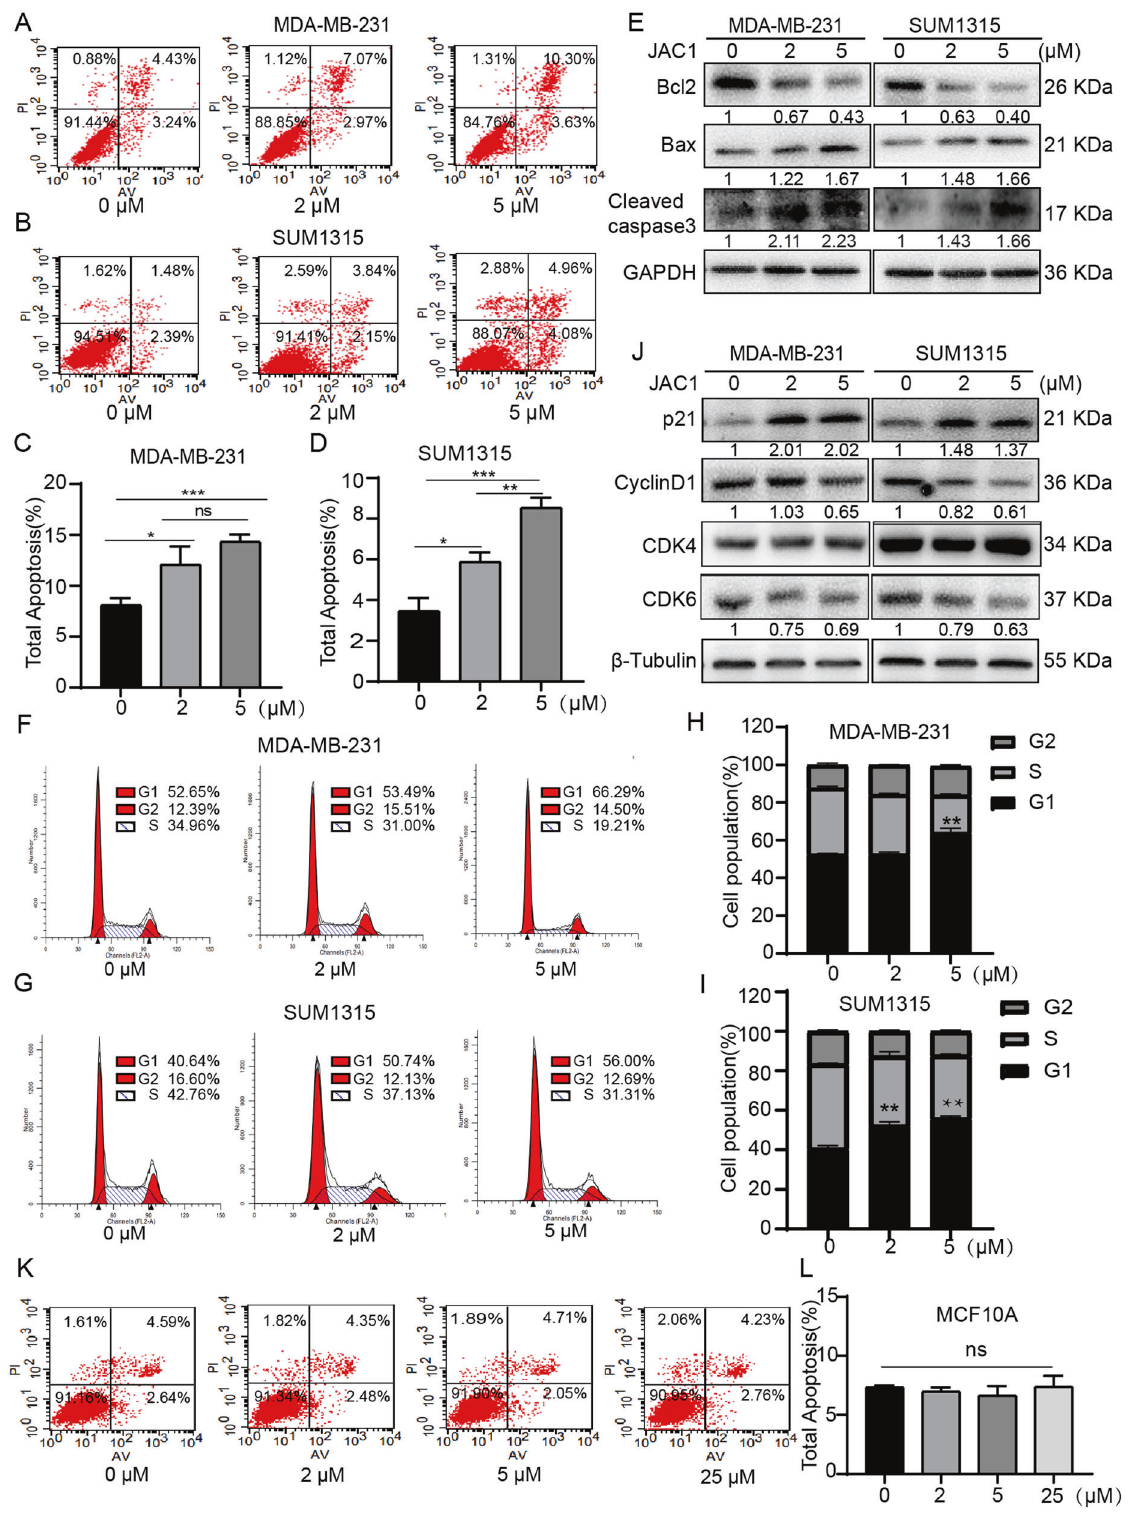
Fig. 3 JAC1 triggers apoptosis and cell cycle arrest of TNBC cells. Apoptosis rate was tested using fl ow cytometry in MDA-MB-231 ( A ) and SUM1315 ( B ) cells after treated with 0, 2, 5 μ M JAC1 for 24 h. The statistics of total apoptosis rate in MDA-MB-231 ( C ) and SUM1315 ( D ) cells ( n = 3). E The expressions of apoptosis-related proteins were determined by western blot After TNBC cells were treated with the JAC1 (0, 2, 5 μ M) for 24 h. Cell cycle analysis was performed using fl ow cytometry in MDA-MB-231 ( F ) and SUM1315 ( G ) cells after treated with 0, 2, 5 μ M JAC1 for 24 h. The statistics of cell population in MDA-MB-231 ( H ) and SUM1315 ( I ) cells ( n = 3). J The expressions of cell cycle-related proteins were determined by western blot in MDA-MB-231 and SUM1315 cells after treated with 0, 2, 5 μ M JAC1 for 24 h. K Apoptosis rate was tested in MCF10A cells using fl ow cytometry after treated with 0, 2, 5, 25 μ M JAC1 for 24 h. L The statistics of total apoptosis rate in MCF10A cells ( n = 3). * P < 0.05; ** P < 0.01; *** P < 0.001. N.S. no signi fi cant